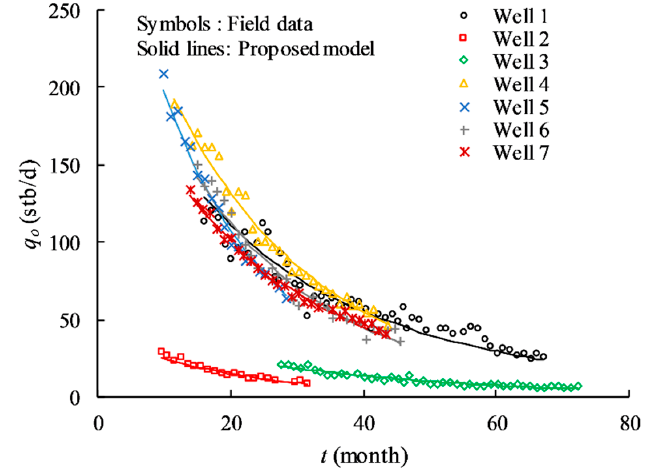
Figure 6. Comparison of predicted and field data of TMS wells. Table 3. Calculated R 2 and AAREP values for TMS wells.